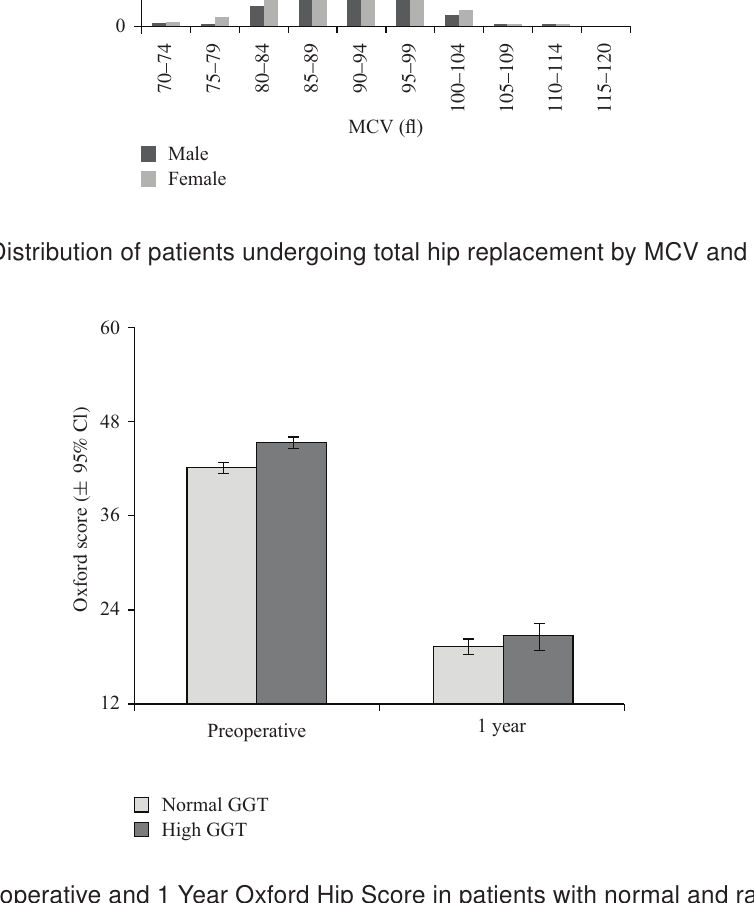
FIGURE 3: Preoperative and 1 Year Oxford Hip Score in patients with normal and raised γ